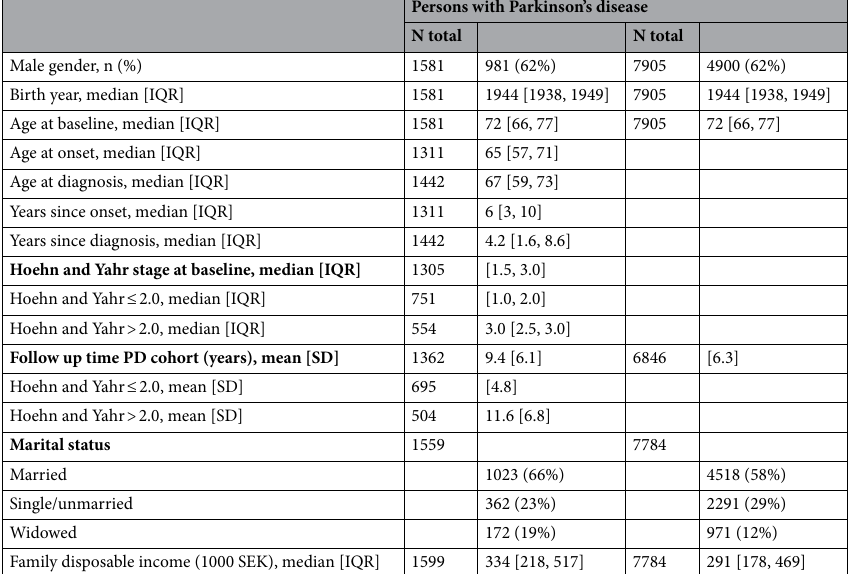
Table 1. Baseline characteristics of the study participants. IQR interquartile range, SD standard deviation.